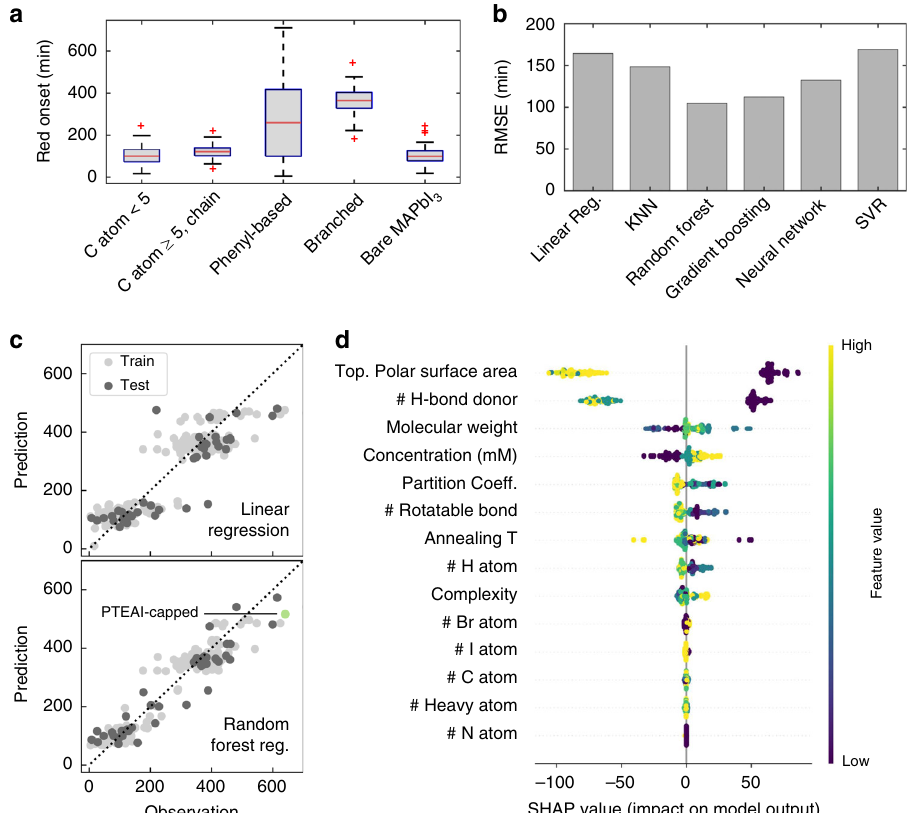
Fig. 3 Image data parameter extraction, regression results, and Shapley-based importance rank. a Extracted red onset points (in minutes) and their distributions from time-dependent camera data of capping-layer groups and bare MAPbI 3 controls, synthesized using 12 different processing conditions. The red line shows the median, and the box shows the upper and lower quartiles. b The cross-validated root mean square error (RMSE) of various machine-learning models, including linear regression, K-nearest neighbors (KNN), random forest regression, gradient boosting regression with decision trees, neural network (multilayer perceptron), and support vector regression (SVR), with non-normalized input. c The comparison of red onset prediction and observation output between linear regression and random forest regression, with the green circle indicating PTEAI-capped fi lm. d The feature importance ranking obtained from the random forest regression algorithm and SHAP library, showing the chemical properties and processing conditions in descending order of importance (rank). The yellow and purple color indicates high and low values of a given feature,